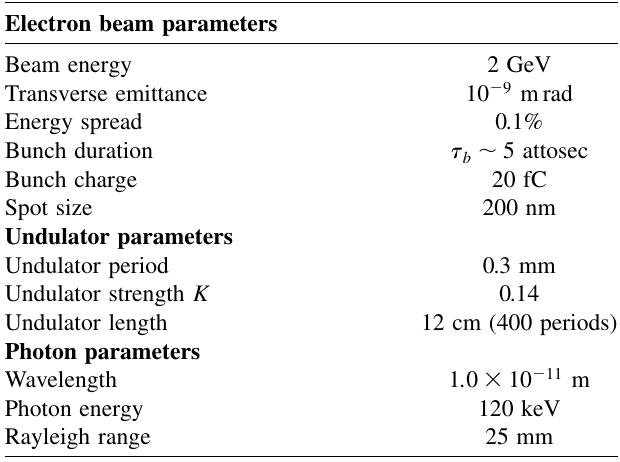
TABLE II. Target electron beam, undulator, and photon pa- rameters.